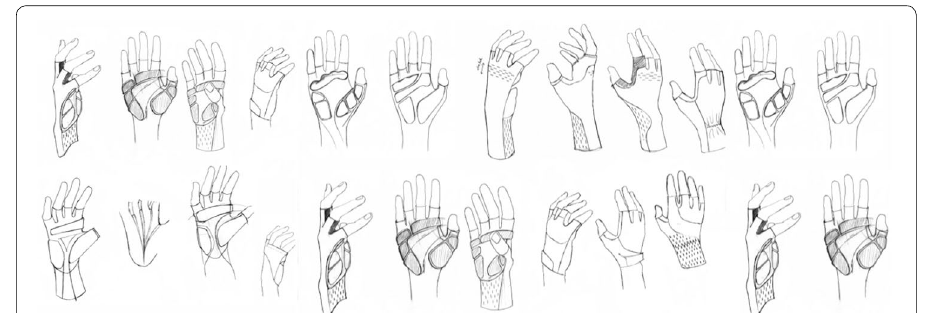
Fig. 14 Cycling glove sketch ideation (Sokolowski and Hoegsted 2019)